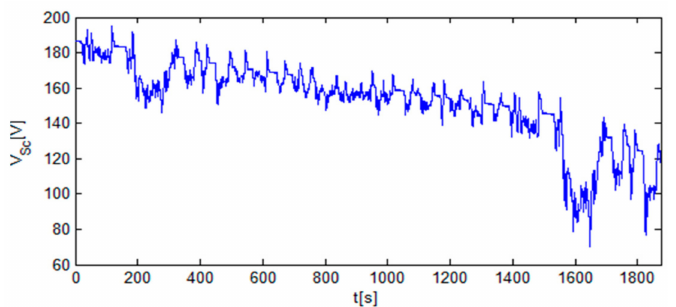
Figure 18. Sc pack terminal voltage.